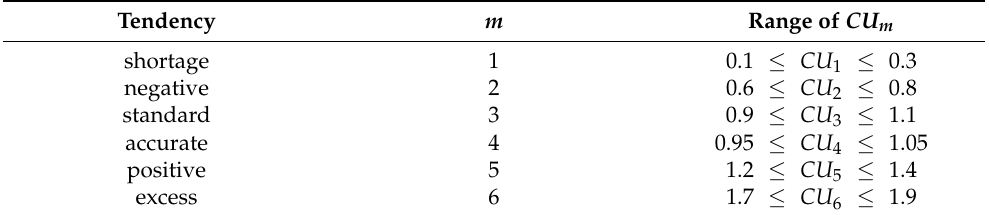
Table 1. Range of CU m